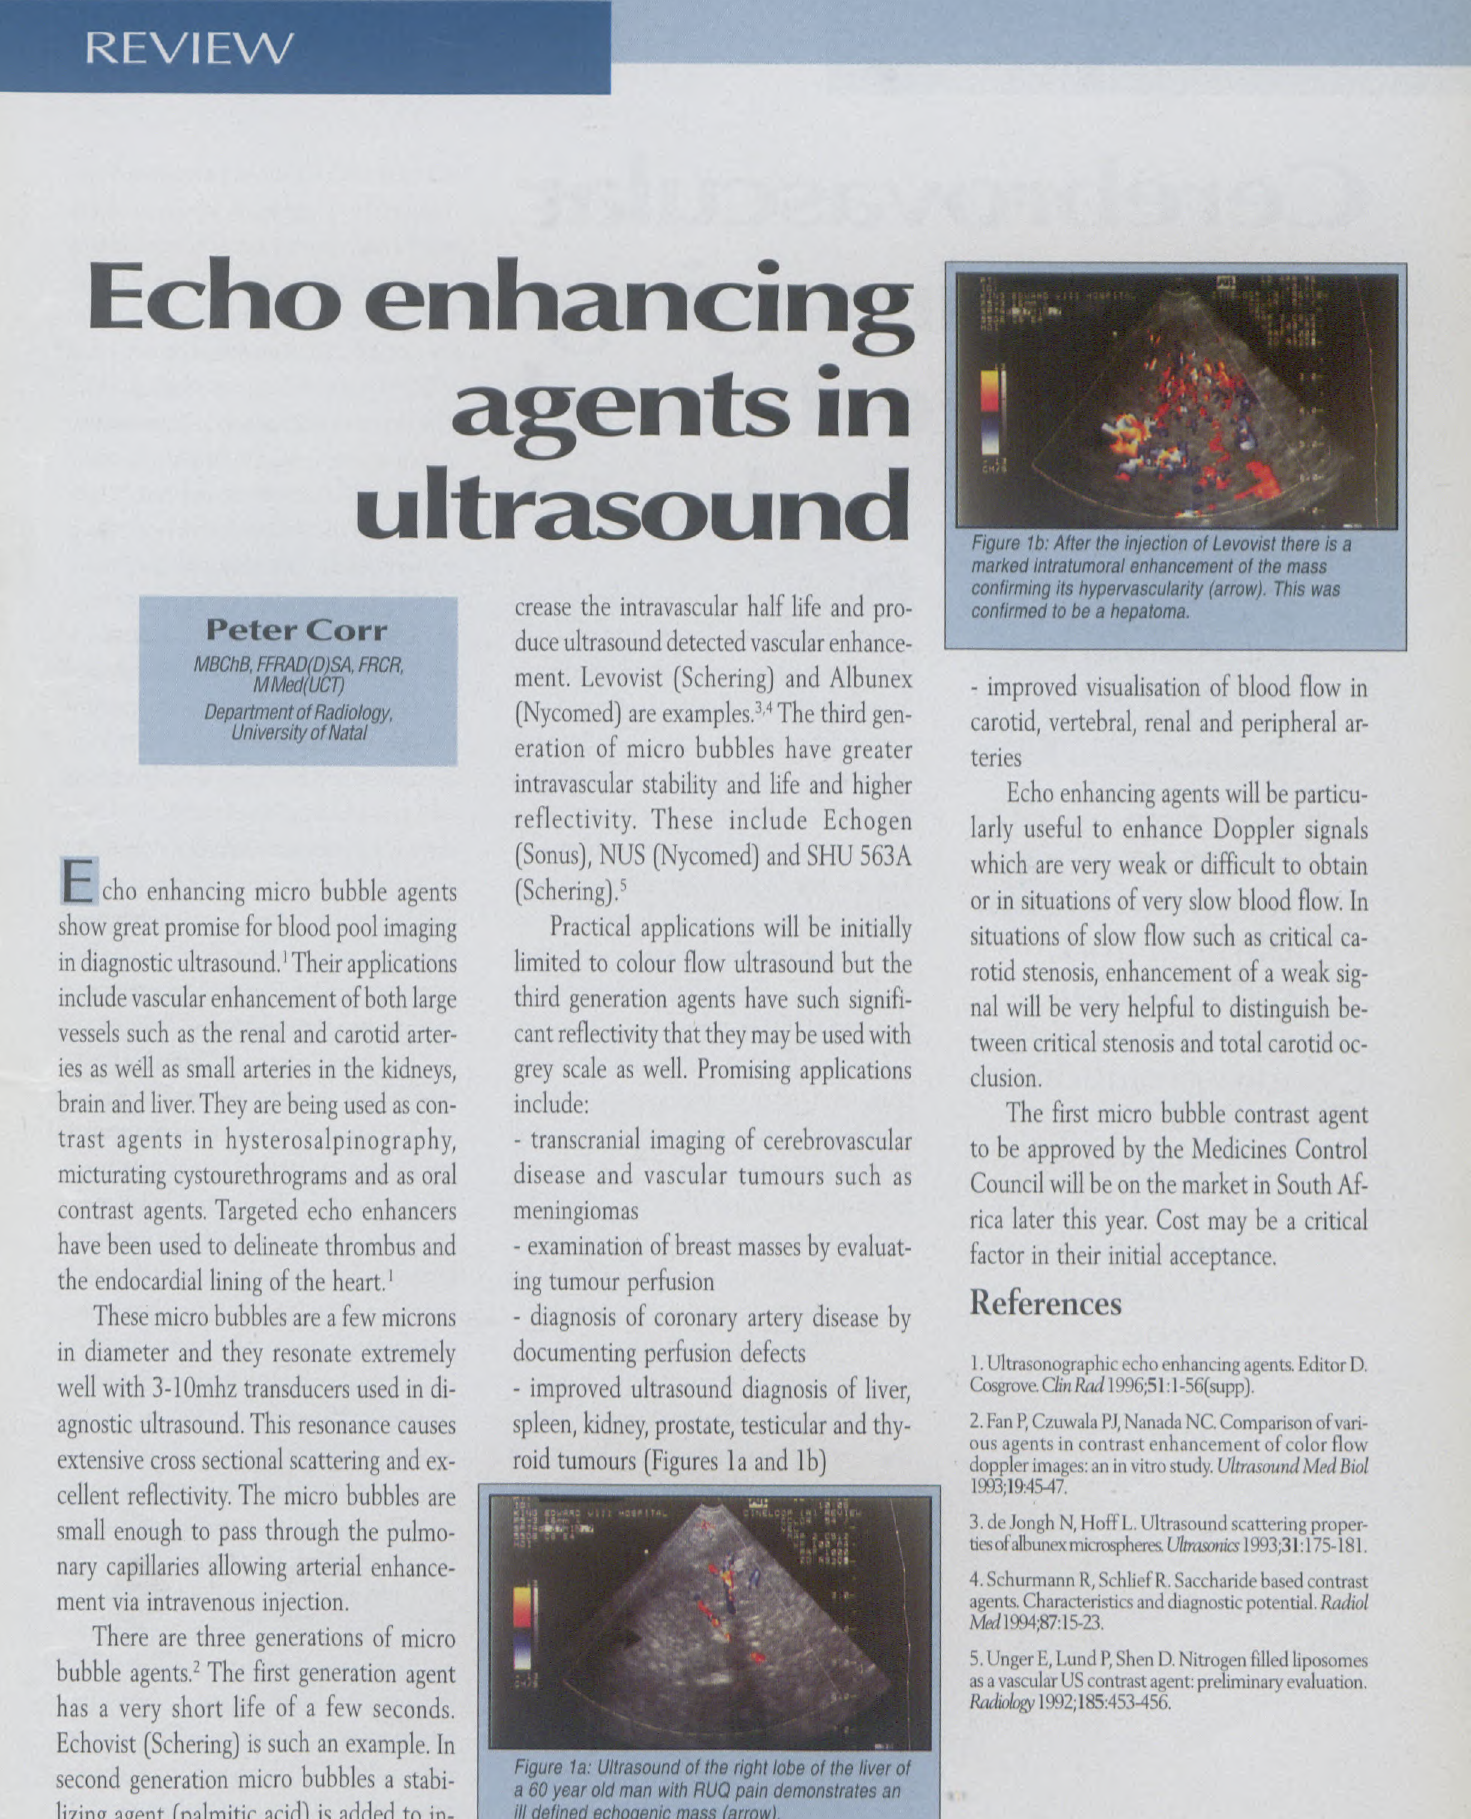
Figure ts: Ultrasound of the right/obe of the liver of a 60 year old man with RUO pain demonstrates an ill defined echogenic mass (arrow).